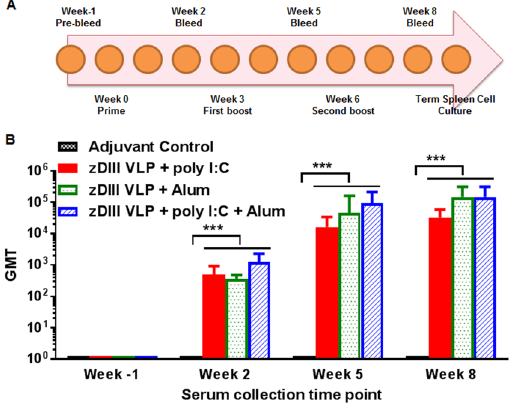
Figure 5. zDIII-specific IgG responses in mice received recombinant HBcAg-zDIII VLPs. C57BL/6 mice were immunized subcutaneously with three doses of HBcAg-zDIII VLP over an 8-week time period ( A ). HBcAg- zDIII VLP was injected on weeks 0, 3, and 6. The indicated adjuvant was used only in the prime injection, but not in the subsequent booster injections. Blood samples were collected on weeks -1 (preimmune bleed), 2, 5, and 8 (2 weeks after each antigen injection) and serum zDIII-specific antibody was measured by ELISA ( B ). The y axis shows the geometric mean titers (GMT) and the error bars show the 95% level of confidence of the mean. *** Indicates p values = 0.0001 to 0.0004 of HBcAg-zDIII-immunized serum compared to that of PBS + adjuvant control.